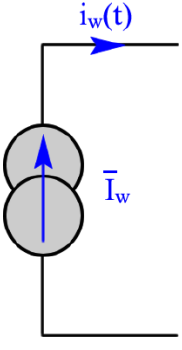
Figure 7. Wind flow equivalent electrical model.